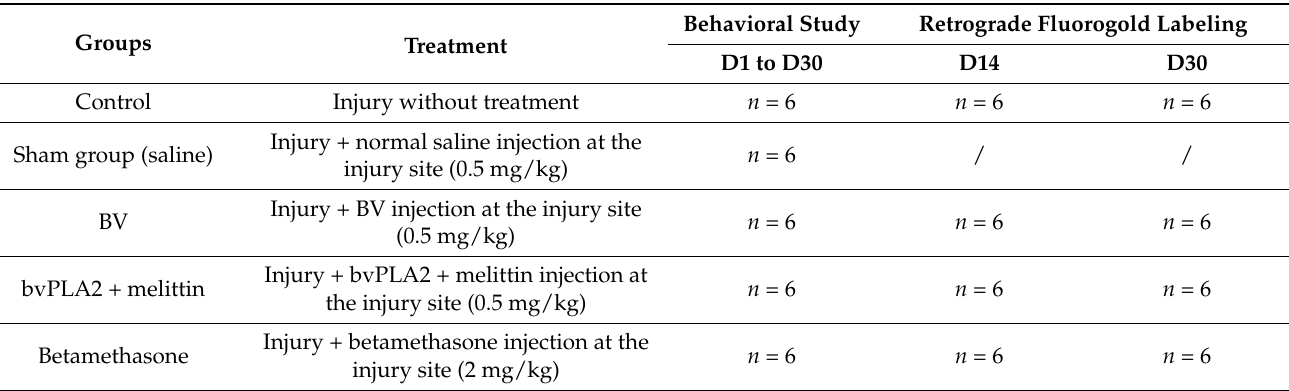
Table 1. Experimental design of the